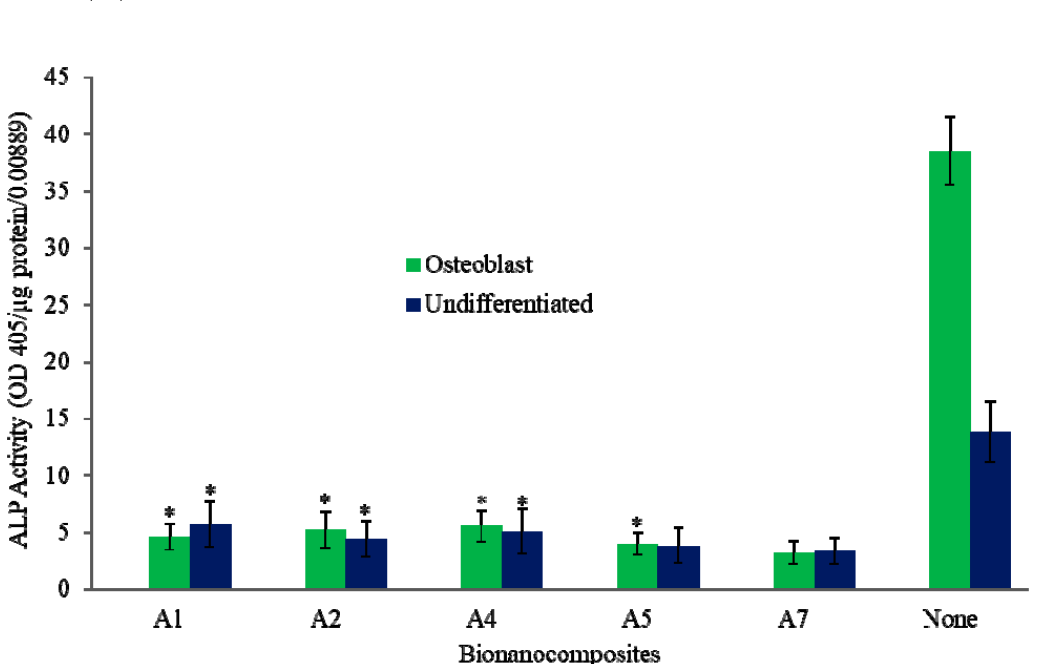
Figure 5. ALP for lysis of bone marrow cells in bionanocomposites with 75% porosity. * represents p < 0.05.